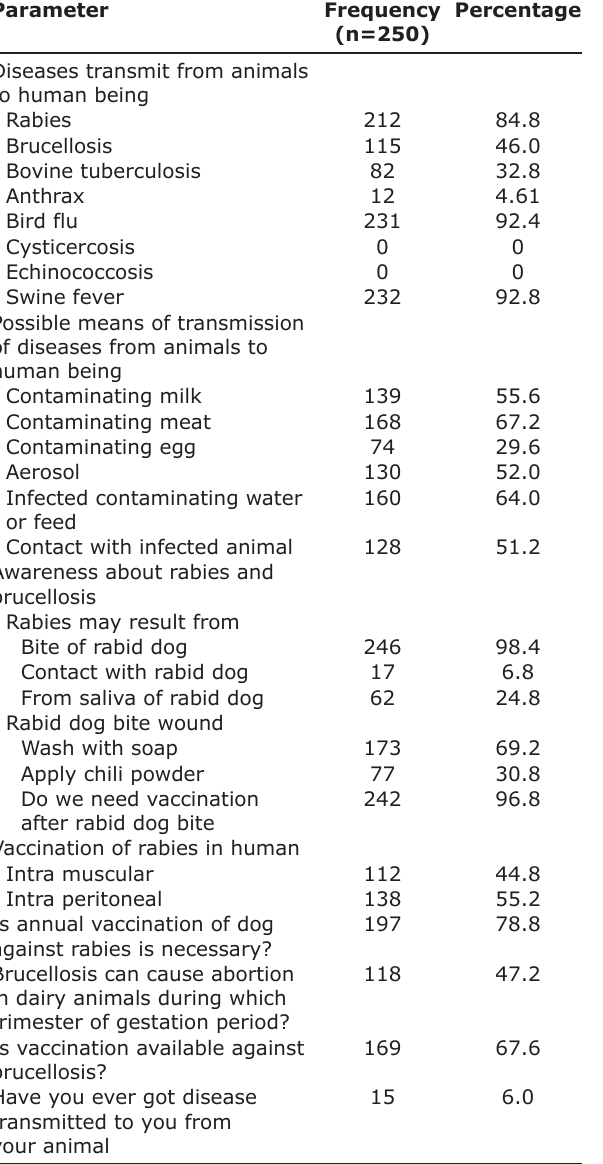
Table-3: Awareness of livestock farmers toward zoonotic diseases and their possible means of transmission. Parameter